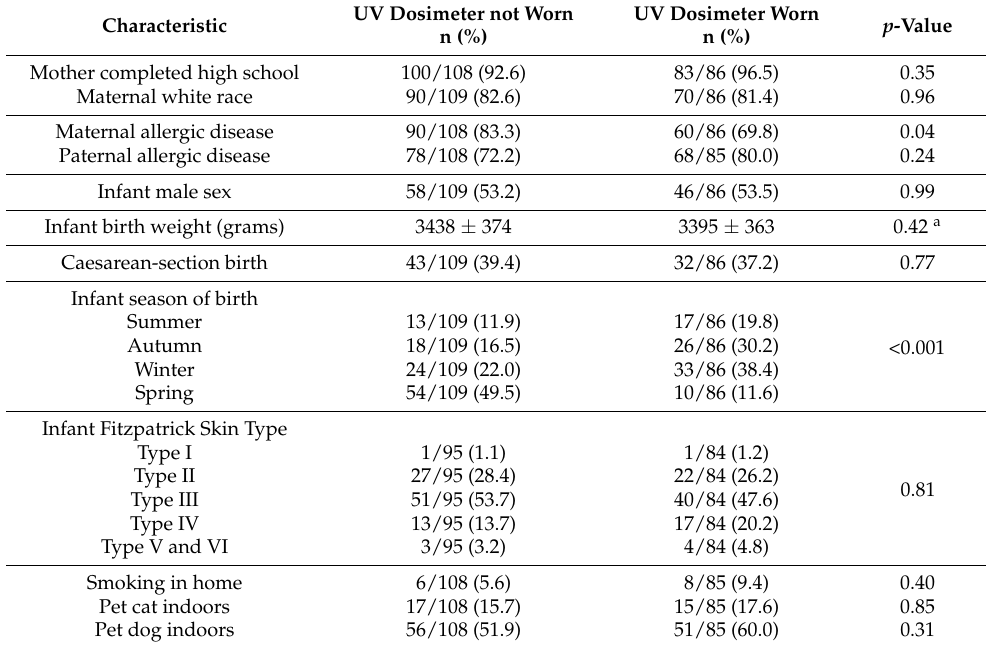
Table 1. Baseline Characteristics: comparing infants who wore the UV dosimeter for the first 3 months (n = 86) to those who did not wear the UV dosimeter (n =